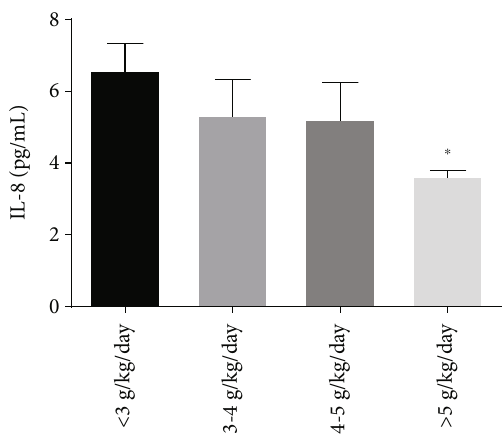
Figure 2: Interleukin- (IL-) 8 concentration of runners with di ff erent levels of carbohydrate intake. The runners were divided in 4 groups in accordance with carbohydrate intake: < 3 g/kg/day and > 5g/kg/day (12 runners). The values are shown as mean